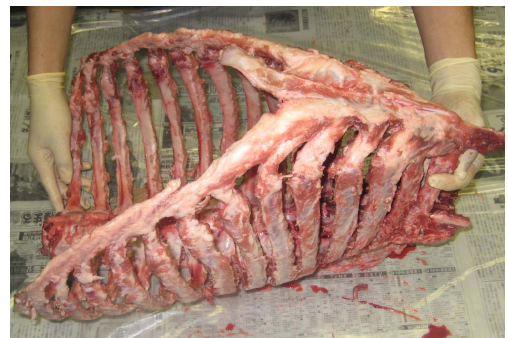
Fig. 2 Thoracic structure of the pig. The bone structure is similar to a